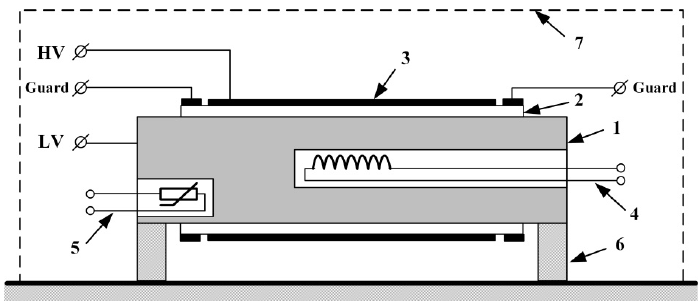
Figure 1. A view of the measuring electrode system and the insulation sample studied: 1—a roll made of brass (low potential electrode), 2—aramid-oil insulation sample, 3—metal foil (high potential